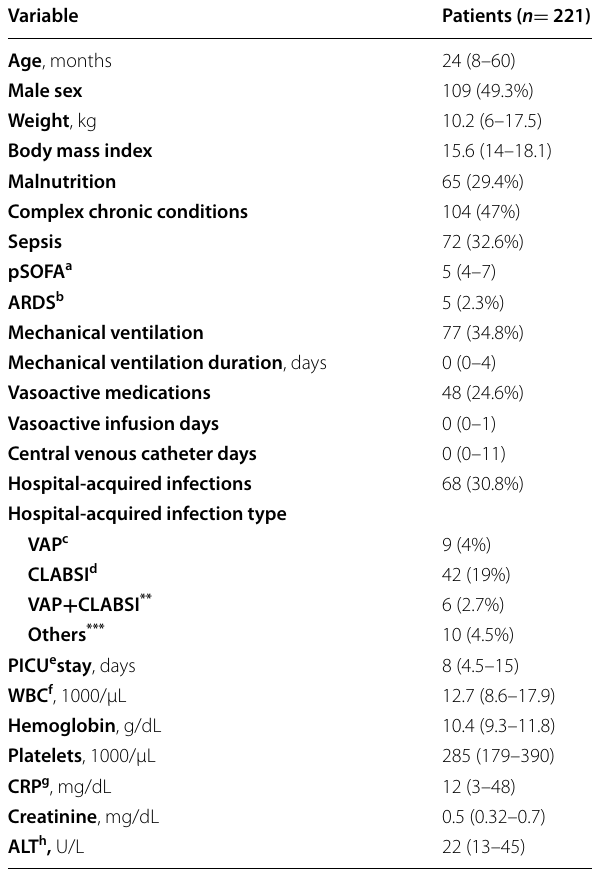
Table 1 Demographic, clinical, and baseline laboratory data